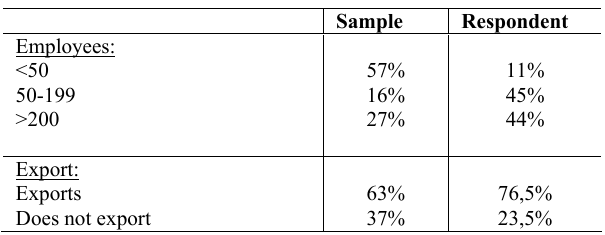
Table 2: Respondents breakdown by size and export compared to